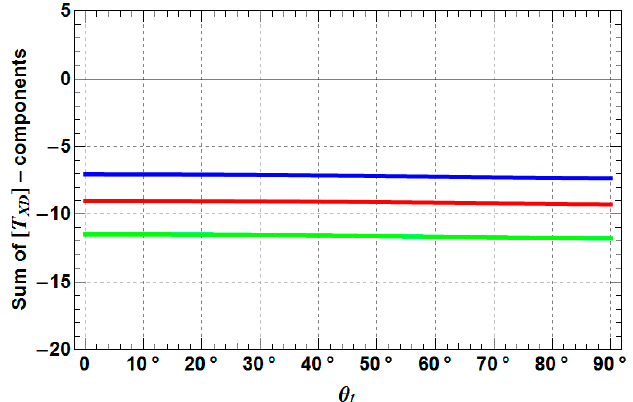
Figure 25. Sensitivity of T XD22 + T XD33 along roughness angle θ 1 ( ε s = 20, ε t = 10, ω l = 30°, ϕ = 0°) with scattering loss L SXD = 1.0 (blue), L SXD = 0.8 (red) and Ls XD = 0.6 (green).